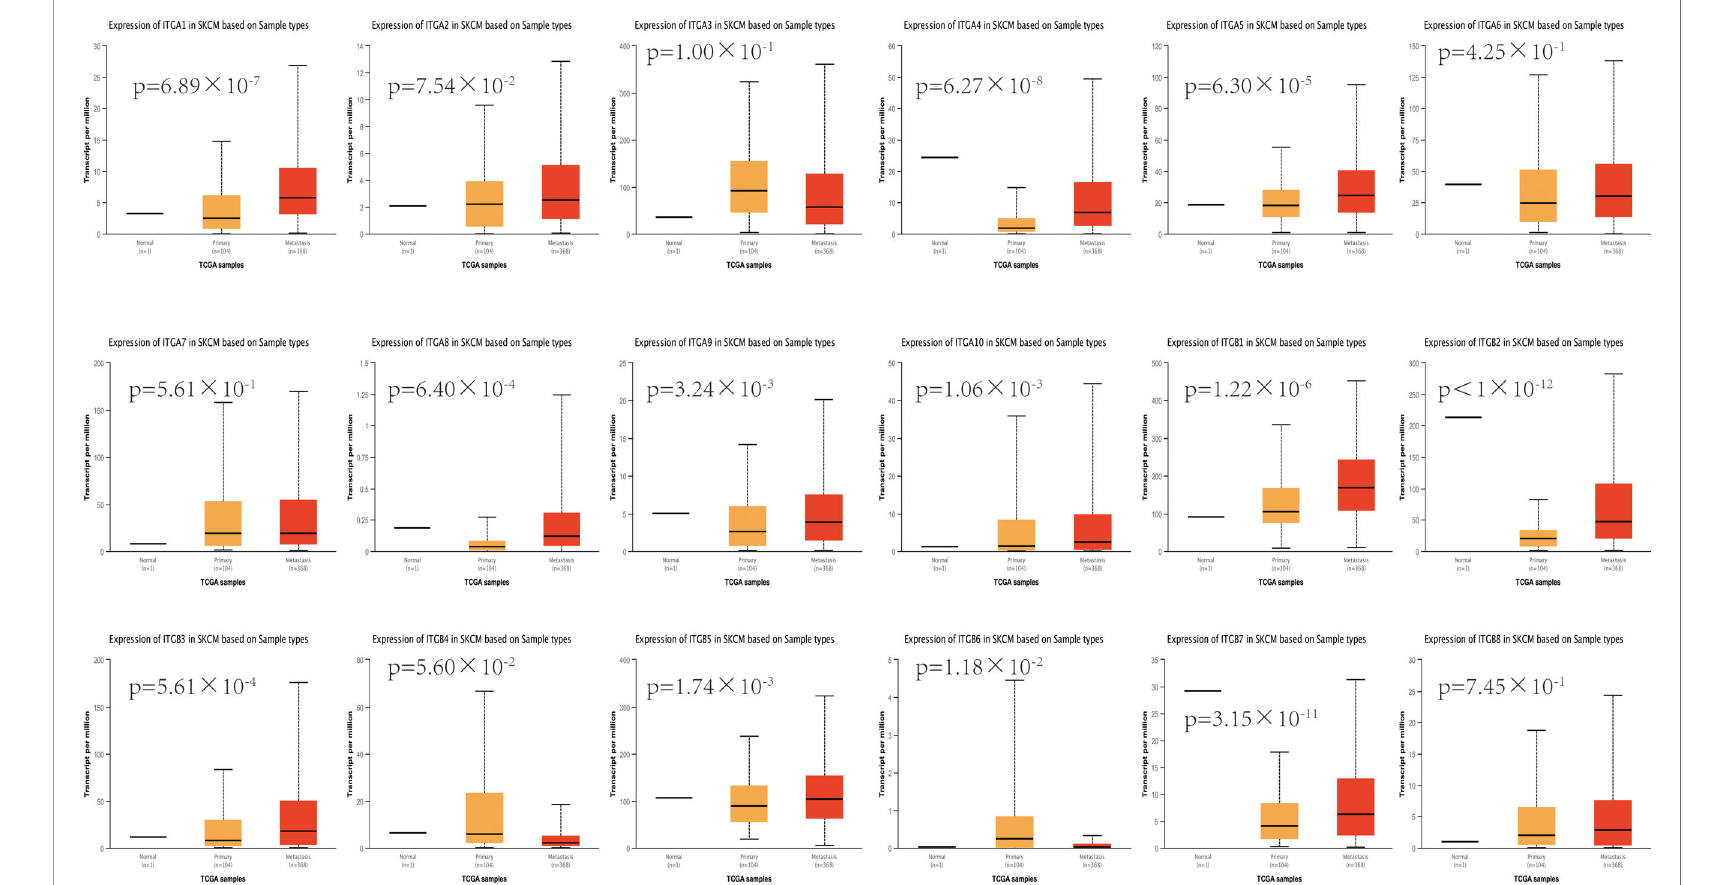
FIGURE 2 | The expression levels of different integrin subunits in primary SKCM samples and metastatic SKCM samples (UALCAN). Student ’ s t test was used to generate a p value. The p value was set at